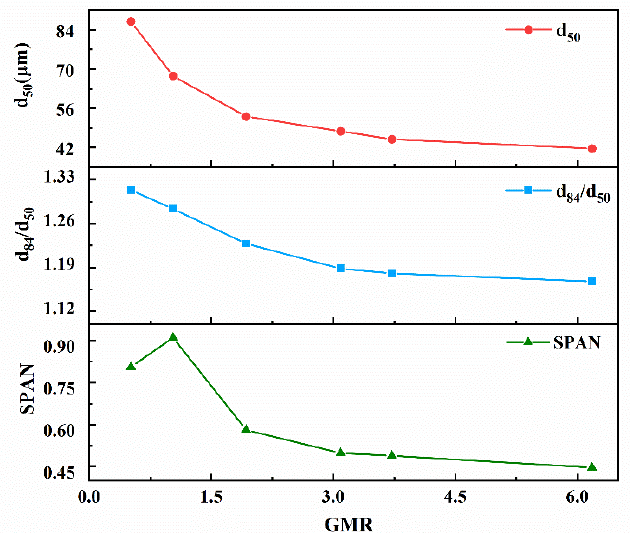
Figure 13. The particle size distribution and cumulative mass fraction for the KHRT breakup model simulation.